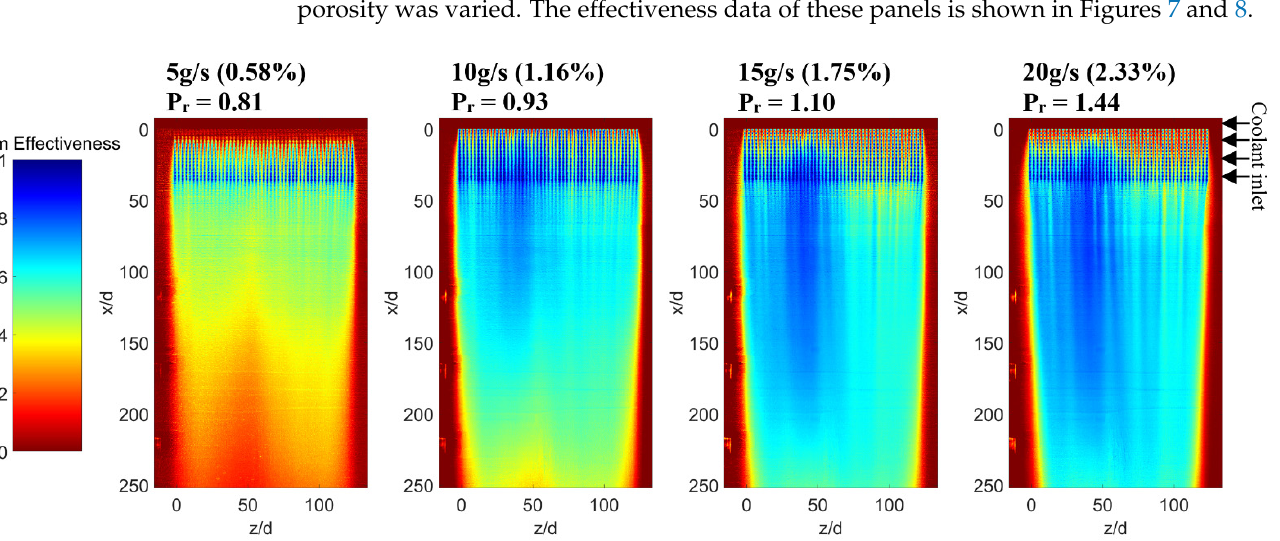
Figure 7. Film effectiveness of Panel 5 at different coolant mass flow rates (mass fraction).